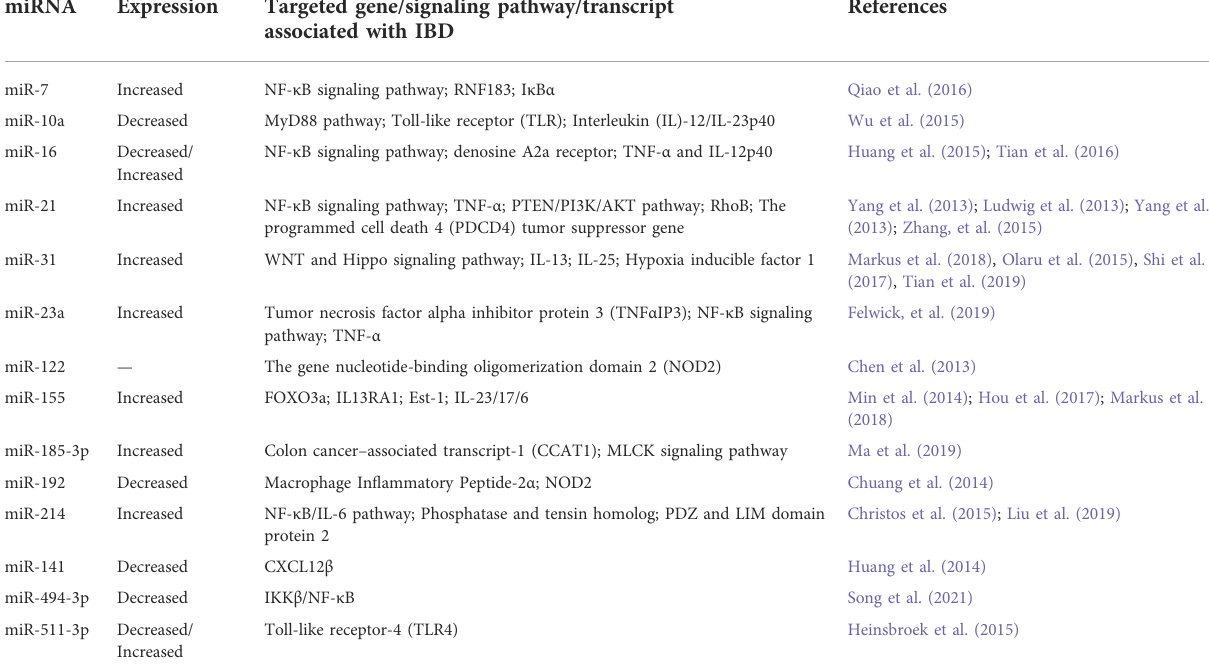
TABLE 1 miRNAs and the targeted genes/signaling pathways/transcripts in IBD patients.